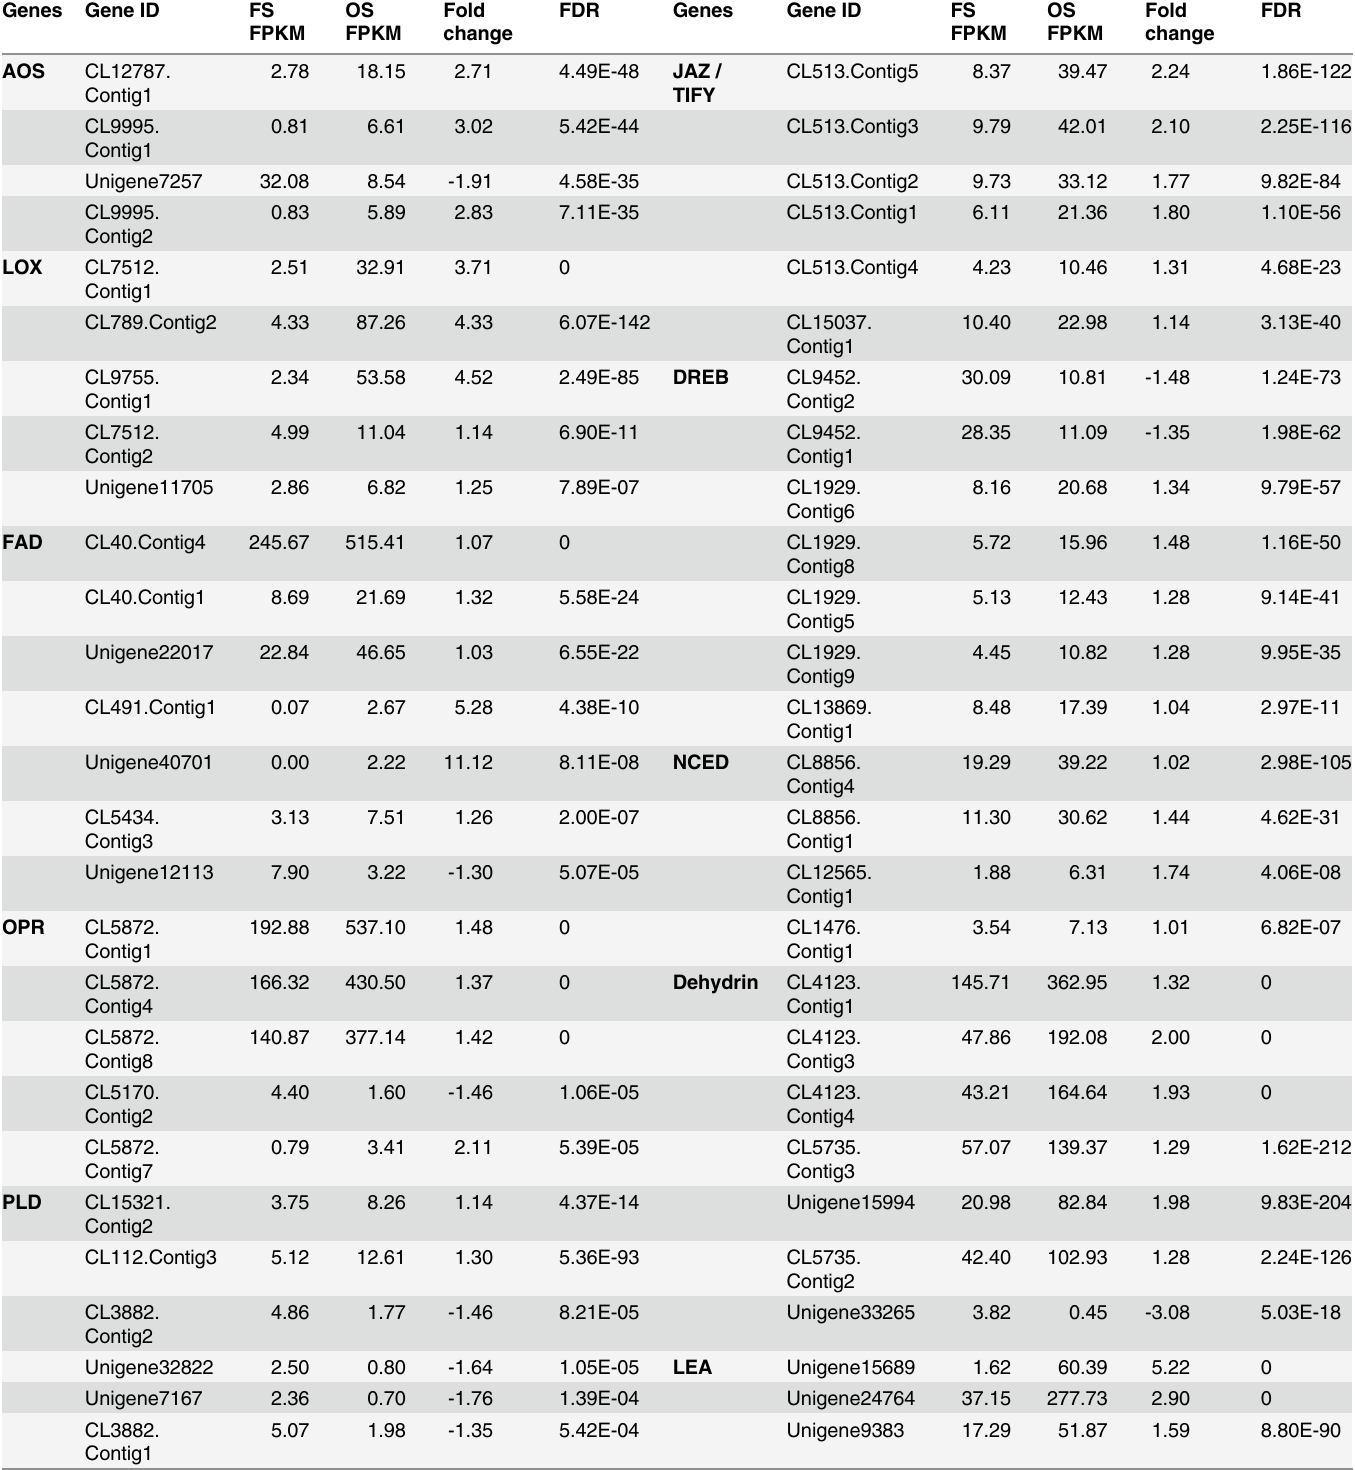
Table 3. The DEGs related to abiotic